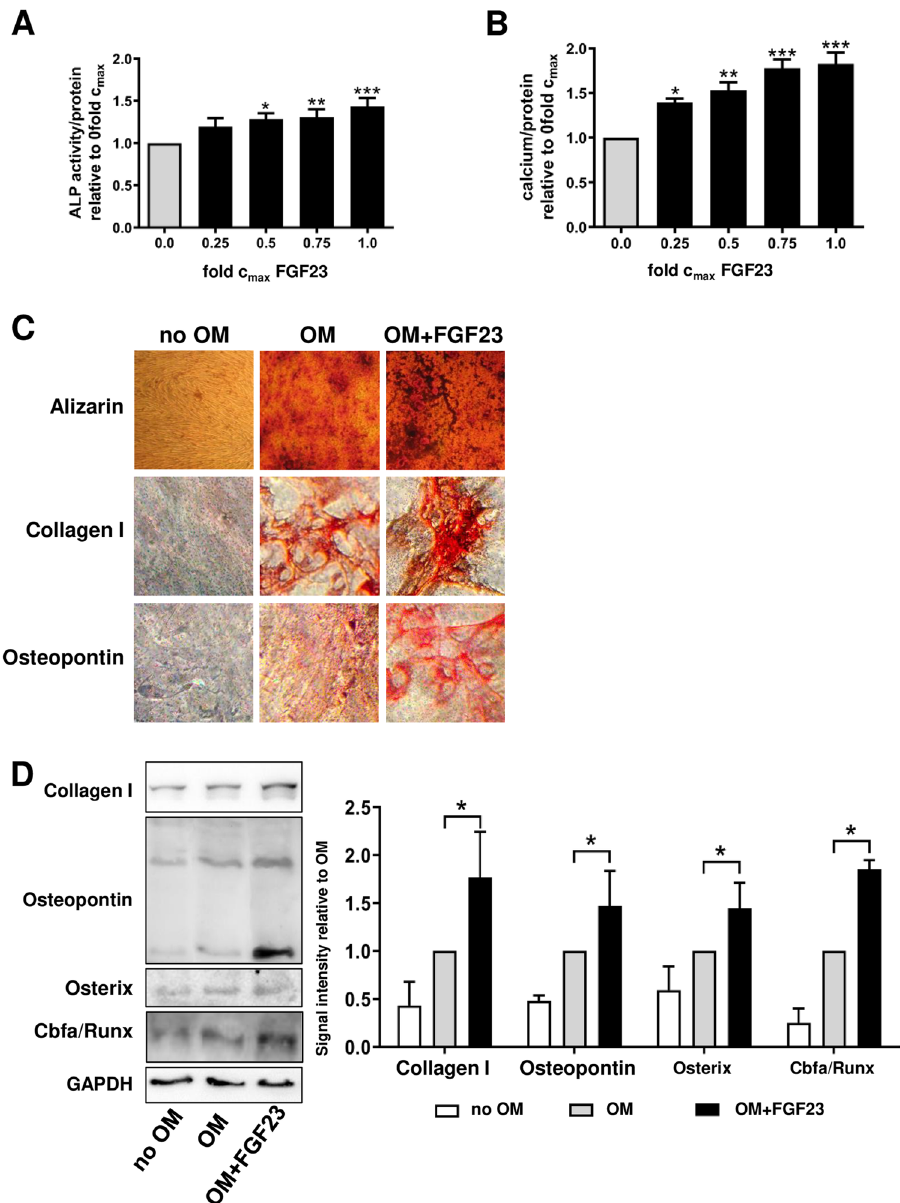
Figure 6. FGF23 induces osteoblastic differentiation in MSC. ( A ) ALP activity in MSC treated with different concentrations of FGF23 in OM for 7 days. ( B ) Calcium deposited by MSC cultured for 3 weeks with increasing concentrations of FGF23 in OM. “fold c max ” denotes the x-fold concentration of the highest reported concentration found in uremic patients. Values were normalized to protein content and are expressed relative to OM without FGF23 (set to 1.00); n = 4. ( C ) Alizarin staining and immunocytochemistry for osteoblast marker proteins after incubation of MSC for 3 weeks in OM with FGF23 at the highest reported concentration in uremia. A representative experiment is shown. ( D ) Western blot analysis for expression of osteoblast marker proteins after treatment of MSC with OM and FGF23 at the highest concentration found in ESRD for 3 weeks. Representative blots and statistical analysis of 3 independent experiments are displayed. * P < 0.05, ** P < 0.01, *** P <